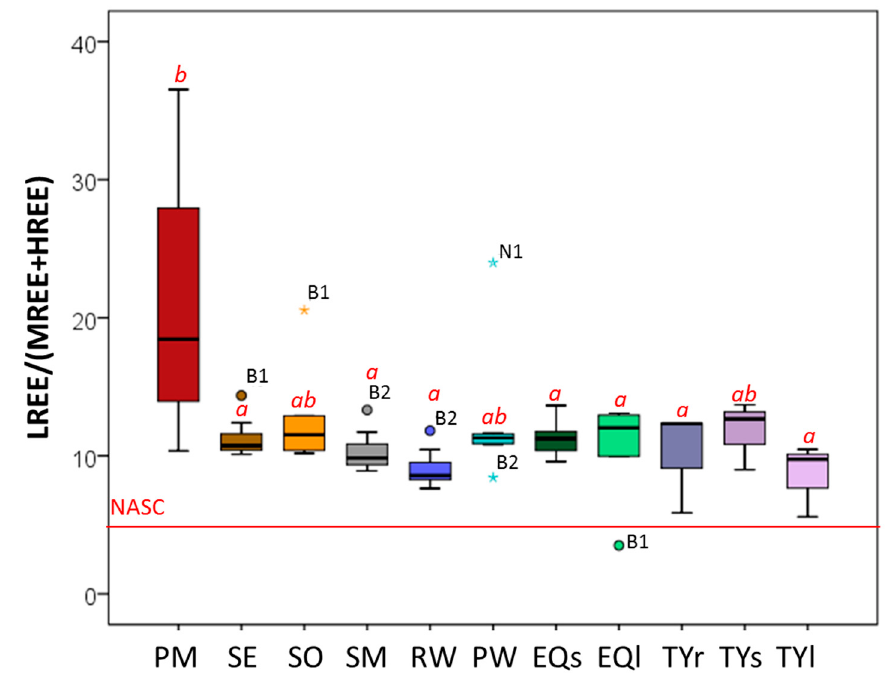
Figure 5. Box plot of the light rare earth element (LREE) / (middle rare earth element (MREE) + heavy rare earth element (HREE)) ratios calculated on the abiotic (PM, SE, SO, SM, RW, and PW) and biotic (EQ, TY) (r: root, s: stem, l: leaf) samples of the study area. The red line stands for the value of the same ratio for the reference standard composition of the North American shale composite (NASC). Different red letters correspond to the significant differences between samples (excluding the NASC value) performed with the post hoc Tukey multiple comparisons test ( p < 0.05).